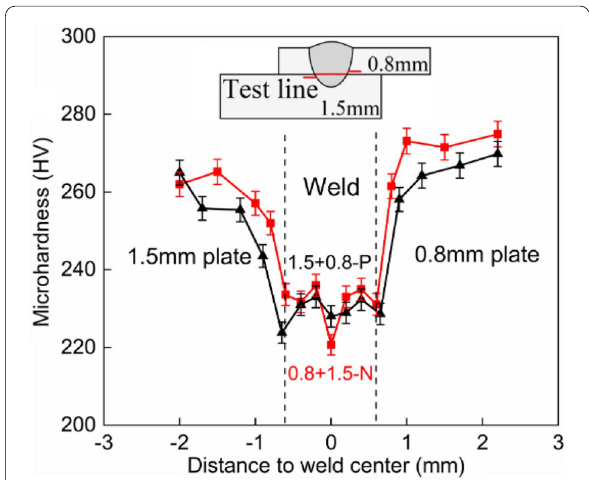
Figure 3 Microhardness profiles of two laser welded joints